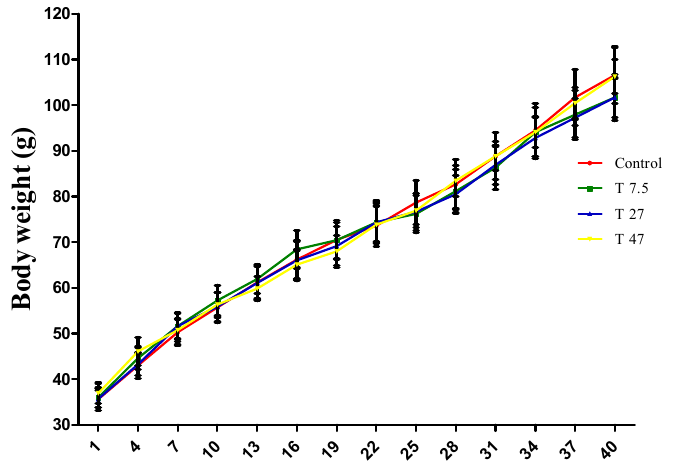
Figure 1. Effects of tartrazine on the bodyweight of immature female Wistar rats during 40 days of treatment. Control = animals receiving vehicle (distilled water, 10 mL/kg BW); T = rats treated with tartrazine at dose of 7.5; 27, and 47 mg/kg BW. Results are shown as a mean ± SEM, n = 5.